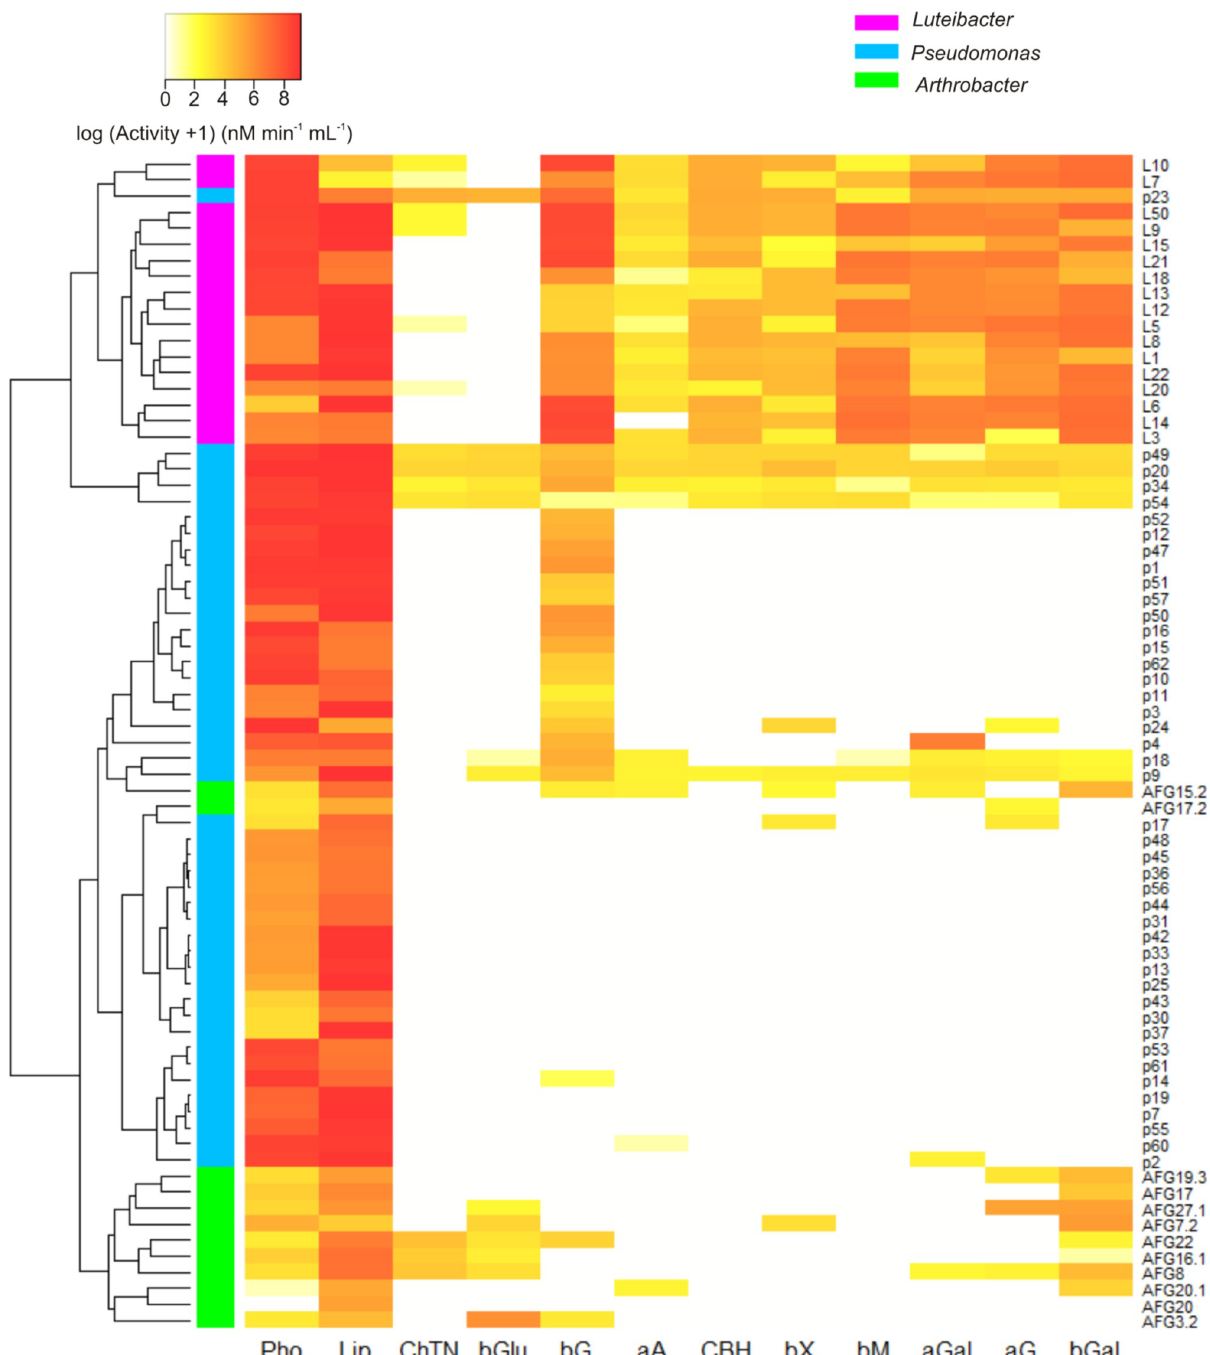
Fig 5. Enzymatic profiles of Luteibacter Pseudomonas and Arthrobacter strains. Data represent means of the total activity of three replicates and were log-transformed to fit the same scale. The clustering was constructed by using UPGMA algorithm based on Euclidean distances. Bacterial genera are colour-coded. Abbreviations of enzymes: Pho: acid phosphatase; Lip : lipase; ChTN : chitinase; bGlu : β -glucuronidase; bG : β -glucosidase; aA : α - arabinosidase; CBH : cellobiohydrolase; bX : β -xylosidase; bM : β -mannosidase; aGal : α -galactosidase; aG : α -glucosidase; bGal : β -galactosidase.